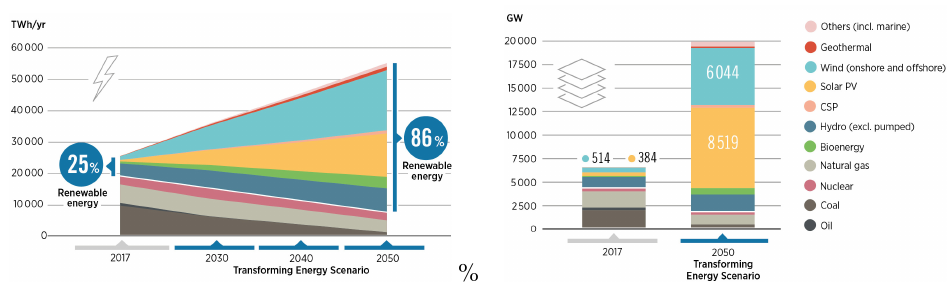
Figure 1. Electricity generation scenario, Remap case 2017–2050, IRENA [5].